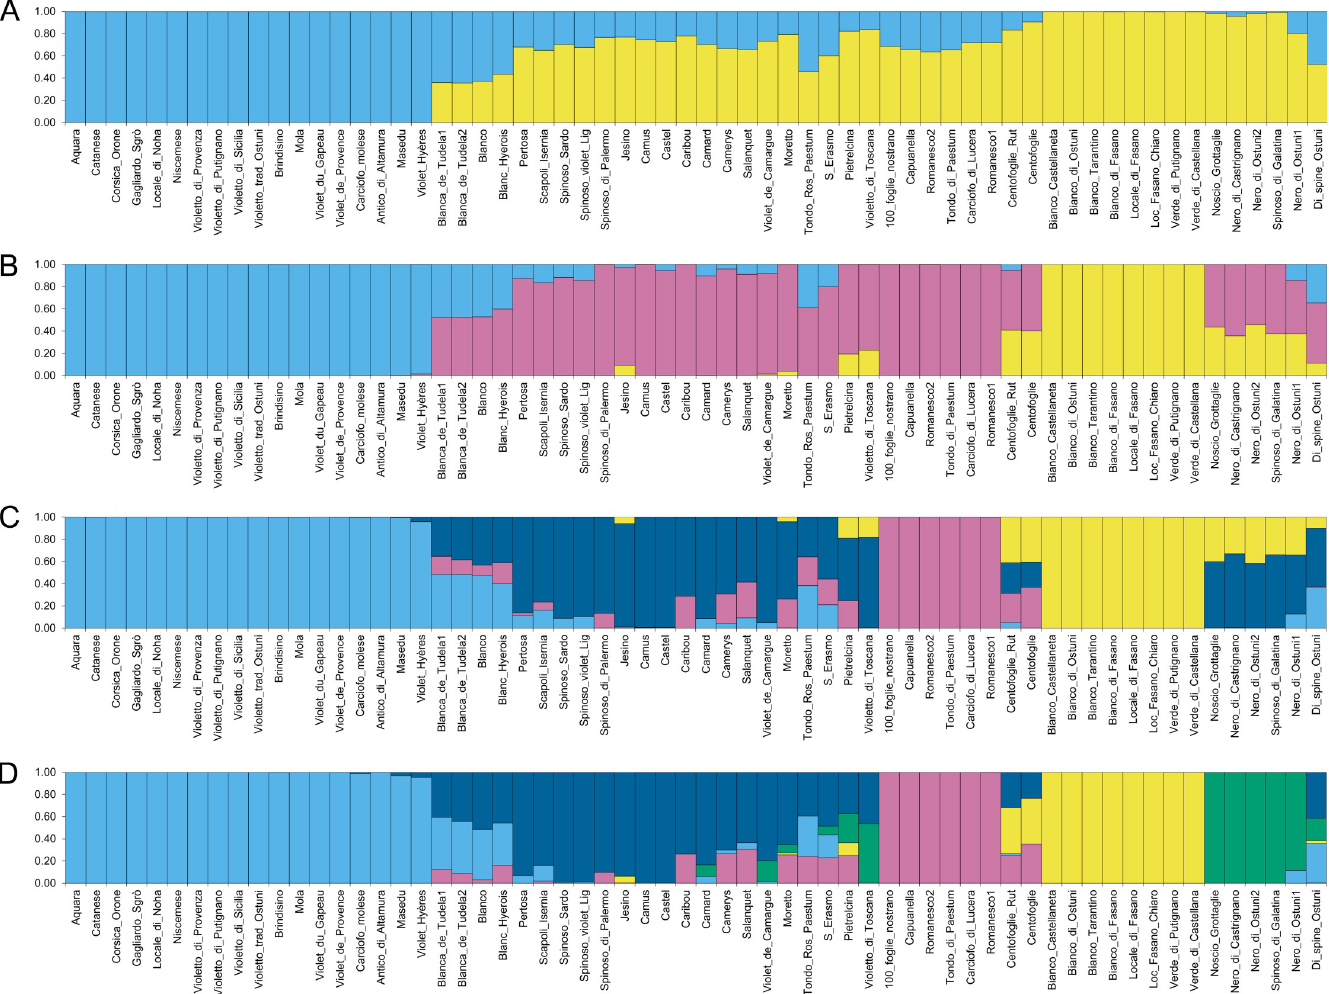
Fig 2. Structure analysis of globe artichoke genotypes. Clusters inferred from the population structure analysis at (A) K = 2, (B) K = 3 and (C) K = 4, (D) K = 5. Numbers on the y-axis show the subgroup membership. Genotype names are reported on the x axis. The colours of the bars indicate the groups identified through the STRUCTURE